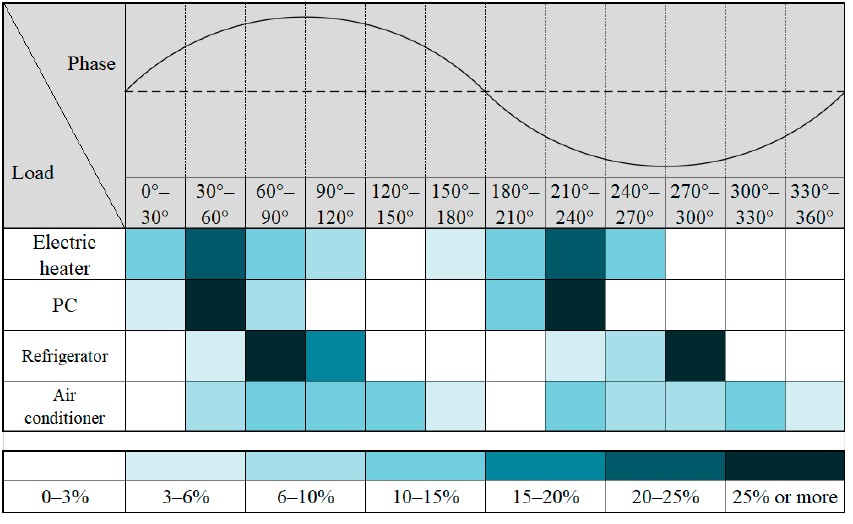
Figure 8. Phase analysis of arc signal.